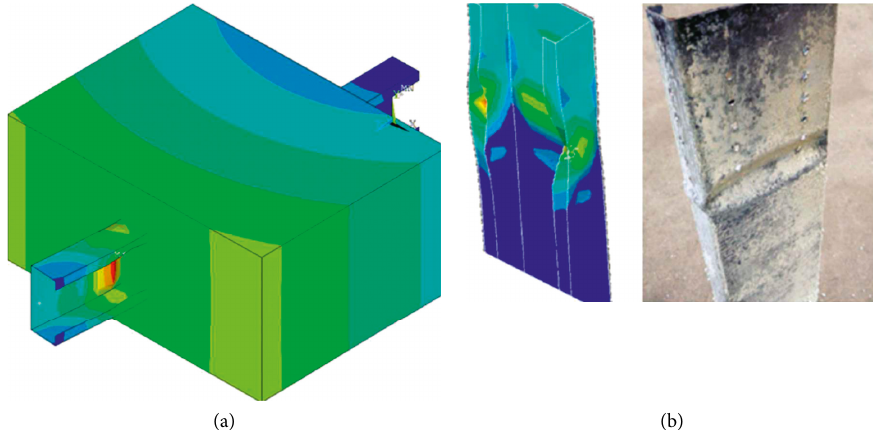
Figure 23: Comparison of local failure between test, FEA with the solid element (a) and FEA with spring element (b) for 300mm braced column.